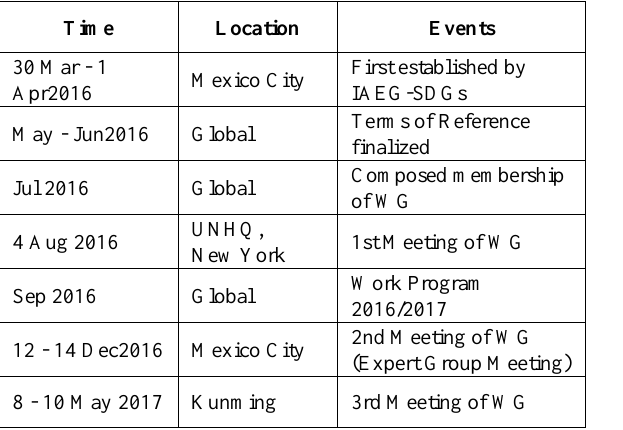
Table 2. The progress of IAEG-SDGs: WGGI.